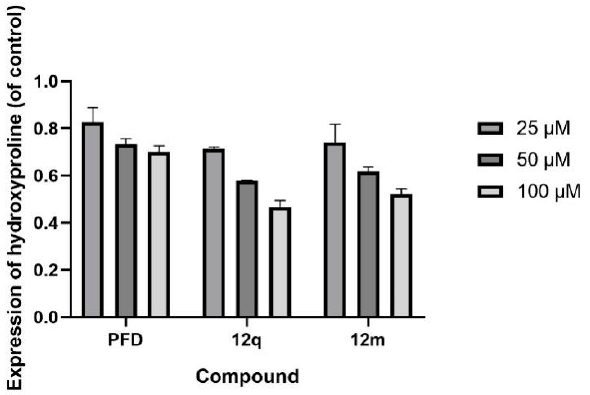
Figure 2. The effect of PFD , 12q and 12m on the expression of hydroxyproline in HSC-T6 cell line.